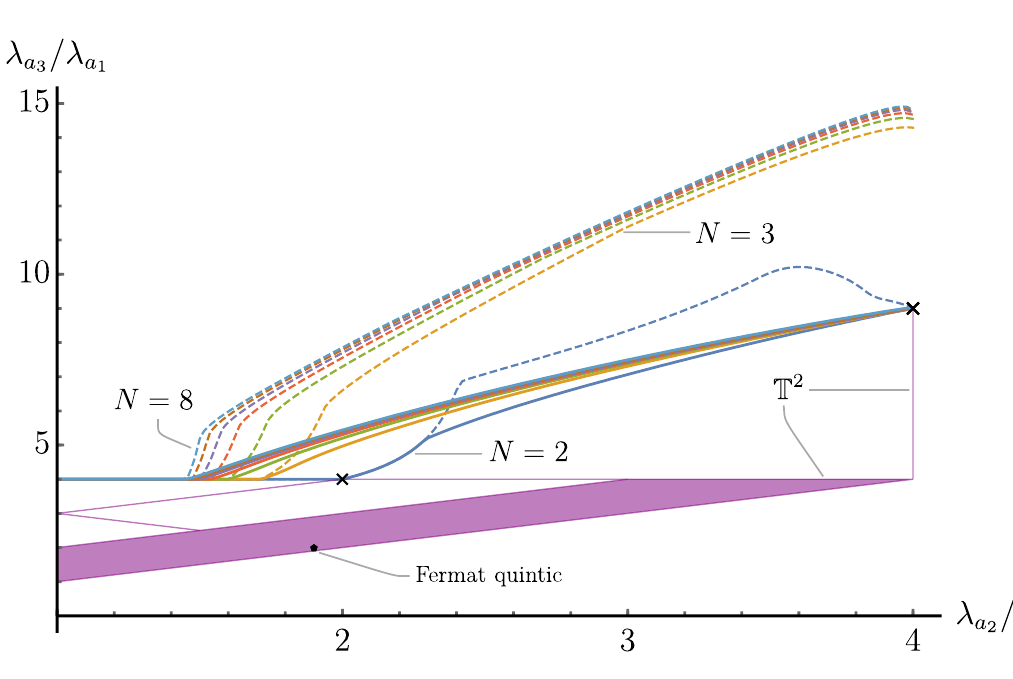
Figure 15 . Upper bounds on (cid:21) a =(cid:21) a on closed Einstein manifolds with R (cid:21) 0 and N = 2 ; : : : ; 8, 3 1 where (cid:21) a 2 f (cid:21) a ; (cid:21) a g [ [ (cid:21) a ; 1 ) and we assume that (cid:21) I (cid:21) 0. The bounds represented by the solid 1 2 3 lines take into account the symmetry of g a , while the bounds represented by the dashed lines 1 a 2 a 3 do not. The purple region, including the various purple lines, covers the image of the moduli space of (cid:13)at 2-tori. The crosses mark the square 2-torus and very long (cid:13)at N -tori, while the pentagon marks the eigenvalues of the Fermat quintic threefold found numerically in ref. [10]. Figure 16 . Upper bounds on (cid:21) a =(cid:21) a on closed Einstein manifolds with R (cid:21) 0 and a Z 2 symmetry 3 1 for N = 2 ; : : : ; 8, where (cid:21) (cid:0) 2 f (cid:21) a g [ [ (cid:21) a ; 1 ), (cid:21) + (cid:21) (cid:21) a , and either (cid:21) I (cid:21) 0 (solid lines) or a a 1 3 2 (cid:21) I =(cid:21) a (cid:21) 4 (dashed lines). The (cid:12)lled circles correspond to the smallest distinct nonzero eigenvalues 1 on S N and the cross corresponds to very long (cid:13)at tori. { 27